Question: Draft a figure caption describing what is shown.
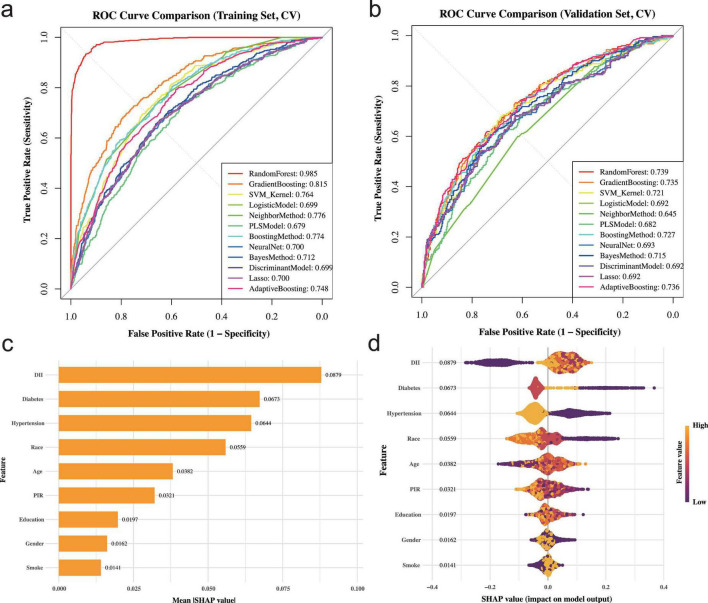
Answer: Machine learning performance and SHAP-based interpretability of predictors for NAFLD. (a) ROC curves comparing the performance of different machine learning models in the training set using cross-validation. (b) ROC curves of the same models in the validation set. (c) Feature importance ranked by mean absolute SHAP values from the random forest model. (d) SHAP summary plot illustrating the direction and magnitude of each feature’s contribution to model output.